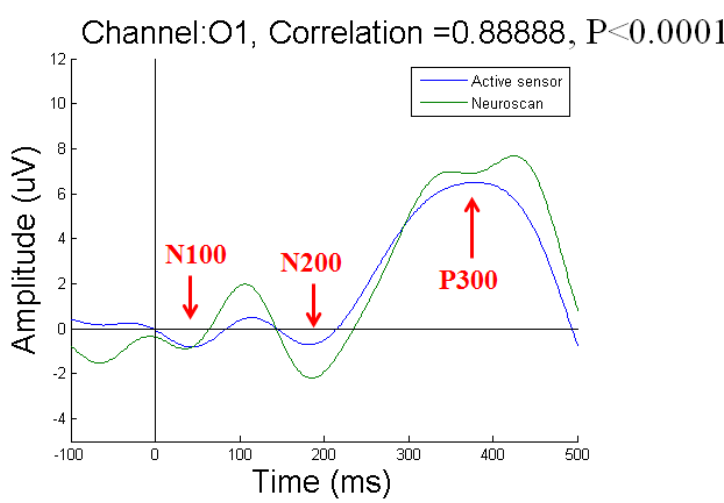
Figure 11. Event-related potential (ERP) results for subject 1 at